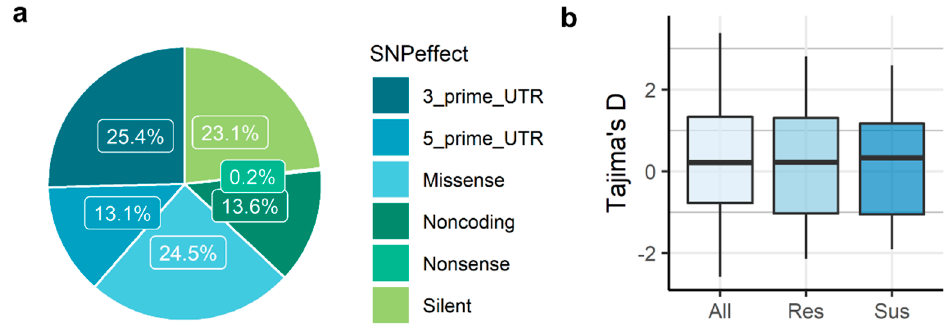
Figure 1. Summary of SNP effects (a) and Tajima’s D estimation for all transcripts (b). Tajima’s D was calculated using a sliding window of 200 bp. All − all samples; Res − resistant; Sus − susceptible.